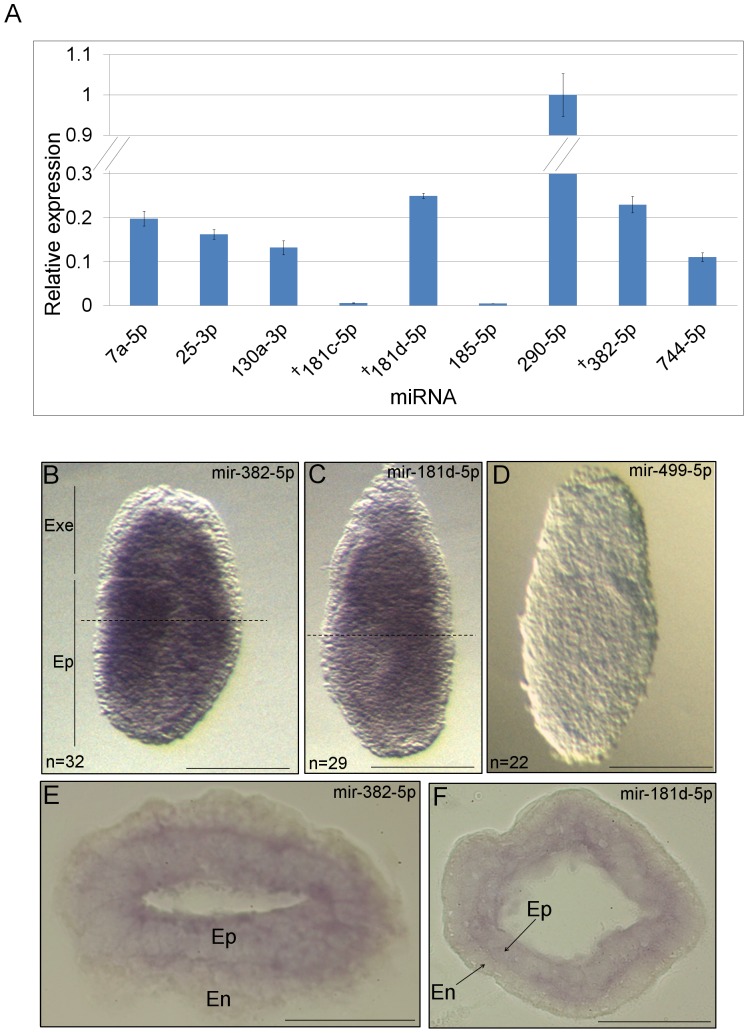
Expression of p-Smad2/3 inducible miRNAs in the early embryo.(A) qPCR was performed on RNA from pooled mouse E6.5 embryos to detect the relative expression levels of the p-Smad2/3 inducible miRNAs. Error bars show ±SEM of triplicate assays. ‘†’ denotes the direct p-Smad2/3 target miRNAs. (B–F) In situ hybridizations were performed on E6.5 embryos using Locked Nucleic Acid modified oligonucleotides against miRs-382-5p (B, E), -181d-5p (C, F) and -499-5p (negative control) (D). Images are representative of 32 embryos for -382-5p, 29 for -181d-5p, and 22 for -499-5p as indicated in the images (n). Dotted lines in (B, C) indicate positions of sections presented in (E, F), respectively. Scale bars for whole mounts indicate 100 µm (B, C, D), and for sections 50 µm (E, F). Extra-embryonic (Exe), epiblast (Ep) and endoderm (En).